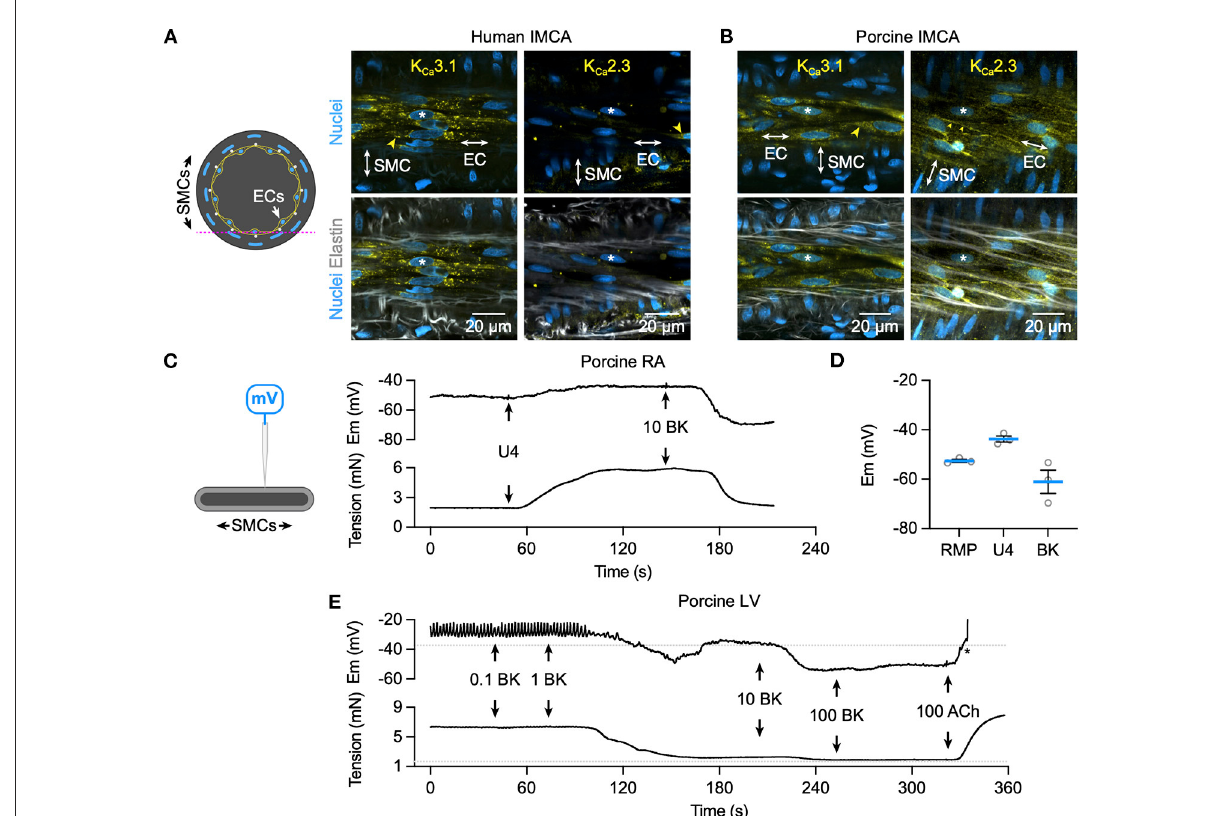
FIGURE6 K + channel expression and hyperpolarization to bradykinin in human and porcine IMCAs. Confocal micrographs of immunolabelling for K Ca 3.1 and K Ca 2.3 in isolated, cannulated and pressurized human (A) and porcine (B) RA-IMCAs with myogenic tone and full dilation to BK. Punctate and diffuse K Ca 3.1 label was evident in the ECs of human and porcine arteries, whereas K Ca 2.3 was less clear in human IMCAs, and highly expressed at EC borders of porcine IMCAs (yellow arrowheads). The elastin was dense in human arteries, with the internal elastic lamina (IEL) seen as longitudinal strings in the porcine arteries. Representative of at least 3 arteries for each label; asterisks indicate corresponding nuclei in upper and lower panels. The pink dashed line in the schematic represents the focal plane. (C) The schematic indicates a sharp microelectrode impaled into a SMC of a porcine RA-IMCA mounted for isometric tension recording. Under control conditions the thromboxane mimetic U46619 (0.6 µ M) depolarized and contracted arteries, and BK (10nM) caused hyperpolarization and relaxation (C) , summarized in (D) . (E) Addition of L-NAME depolarized and contracted porcine left ventricular (LV)-IMCAs. Under these conditions BK (0.1nM to 100nM) repolarized and relaxed the artery. Addition of 100nM acetylcholine (ACh) depolarized and contracted the artery. The asterisk indicates when the electrode came out of the cell. The RMP and tension prior to the addition of L-NAME (100 µ M) are indicated by dashed lines. Drugs were added to a static bath at the arrows. RMP, resting membrane